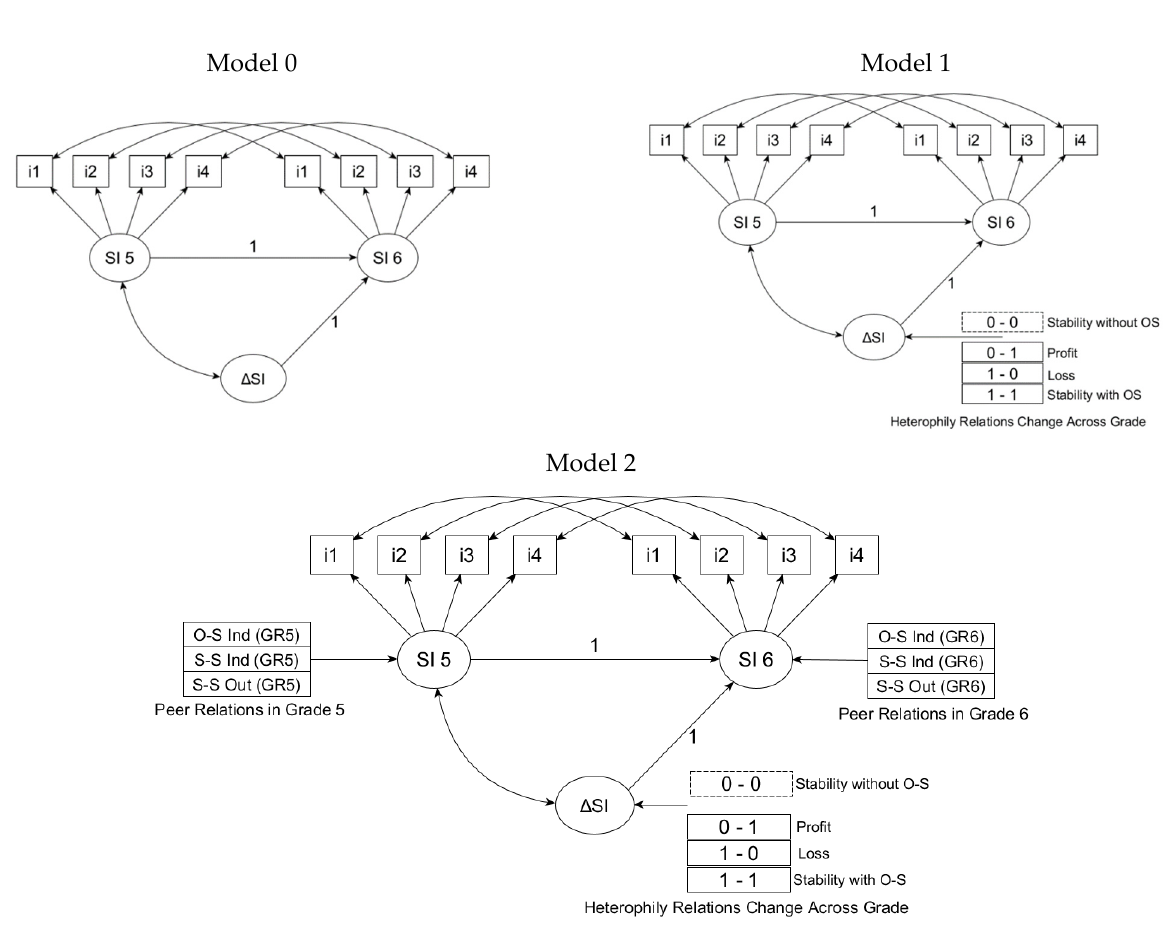
Figure 3. The schemes of the tested latent difference score (LDS) models for the latent variable PIQ-SI measured at two points in time (Grade 5 and Grade 6). Model 0 = unconditional LDS model. Model 1 = conditional LDS model (with predictors that reflected the changes in heterophilic preferences among adolescents between the beginning of grade 5 and the end of grade 6. Model 2 = conditional LDS model (with three additional indices of peer relationships. S-S = same sex; O-S = other sex; Out = out-degree; Ind = in-degree; GR = grade. SI 5 = Sense of peer integration in grade 5; SI 6 = Sense of peer integration in grade 6; ∆ SI = Difference in sense of peer integration between grade 5 and grade 6 (latent difference score). i = items of the PIQ-SI